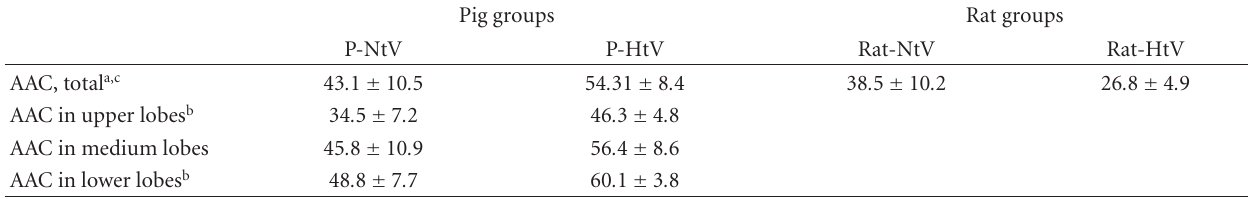
Table 3: Area of alveolar collapse in morphometric